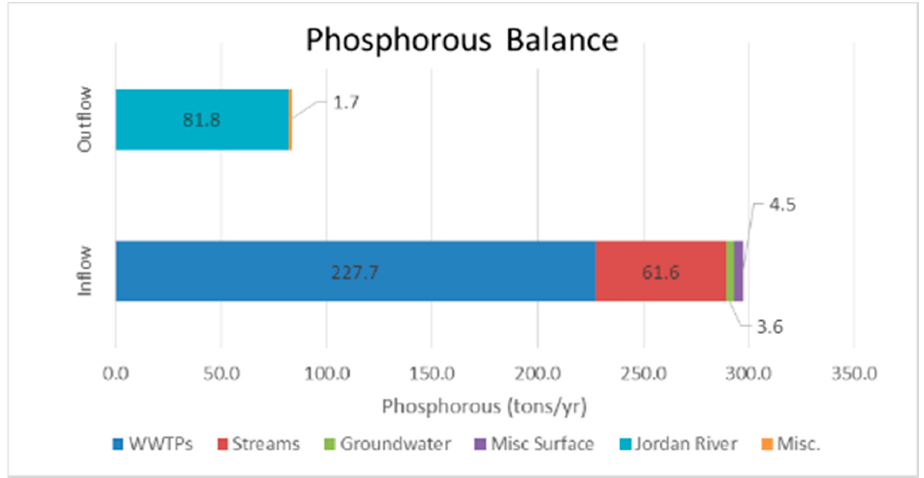
Figure 3. Summary of the total phosphorus load and exports from Utah Lake [1].